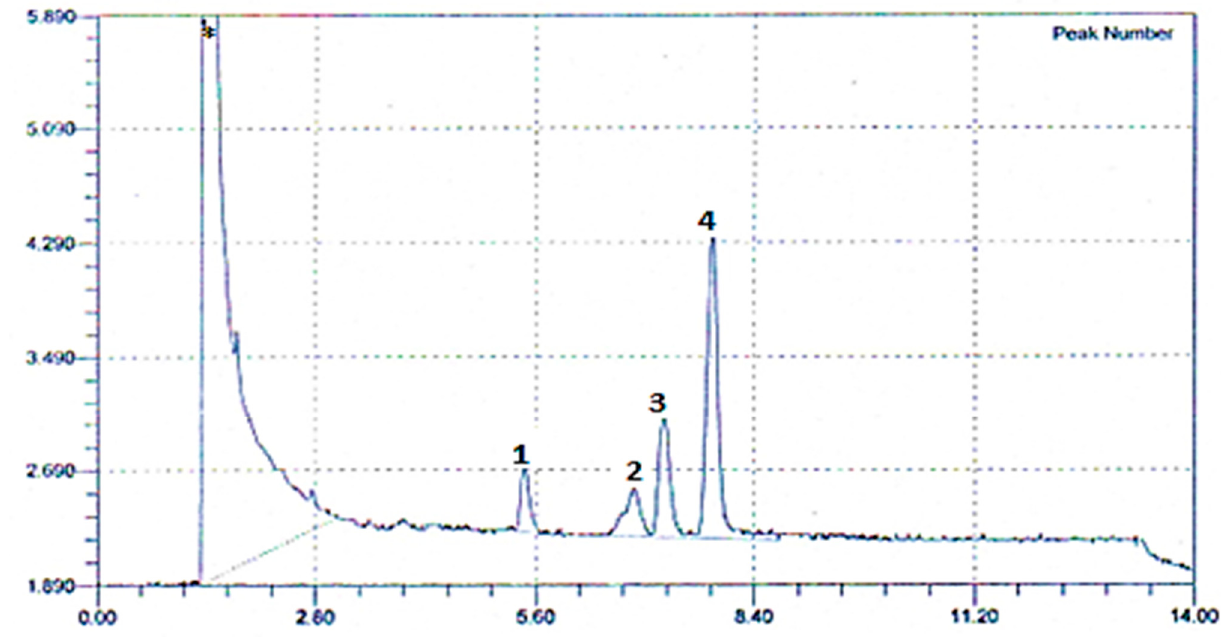
Figure 18. Algae at 4 mL/L G.L.C. (* is the solvent, 1 is the palmitic acid, 2 is oleic acid, 3 is a Linoleic acid and 4 is the α - α linolenic acid ) of chia ( Salvia hispanica L.) fixed oil content as impacted by various treatments.